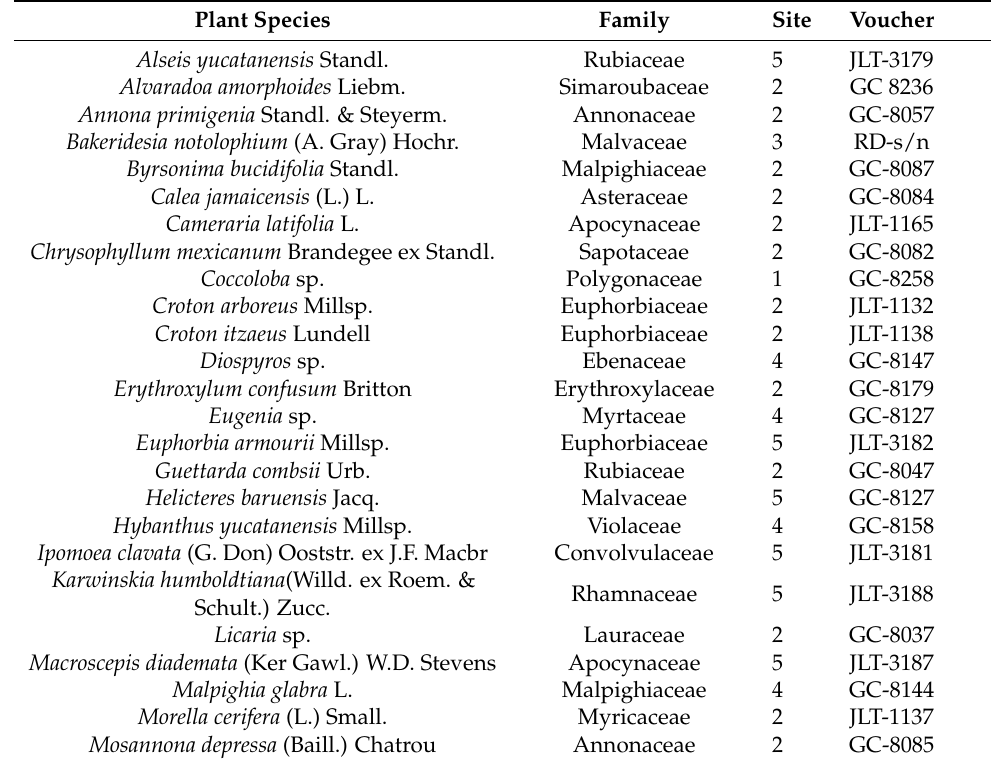
Table 1. Native plants from the Yucatan Peninsula evaluated against second-stage juveniles of Meloidogyne incognita and M. javanica